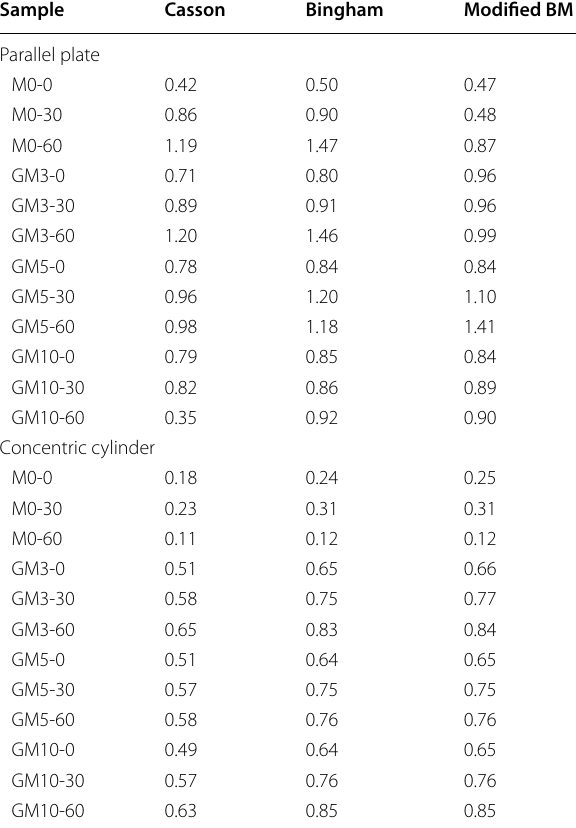
Table 12 Influence of resting time on plastic viscosity.